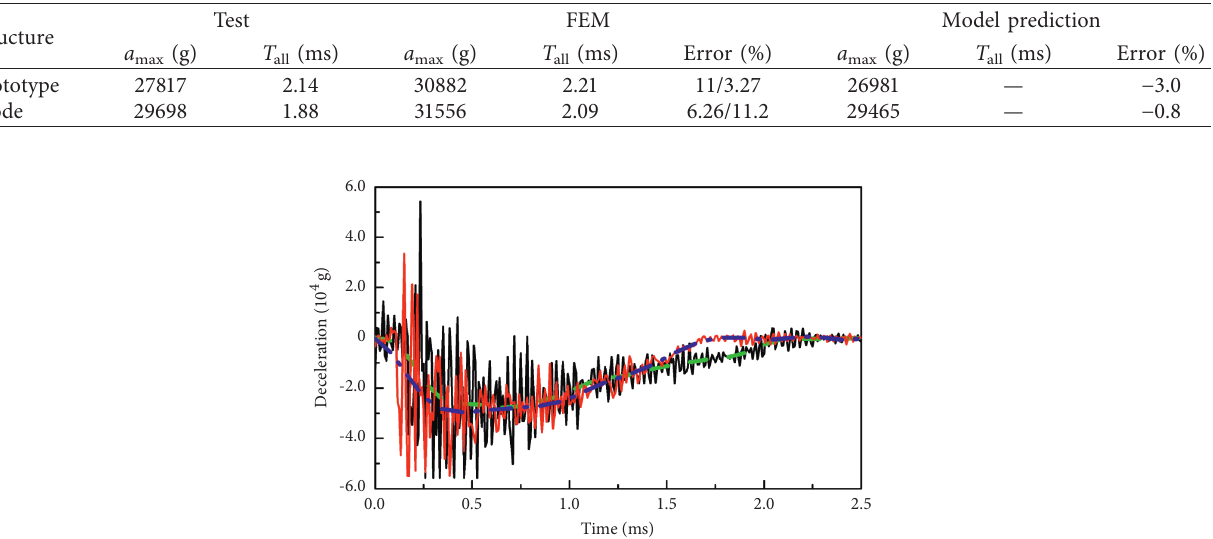
Table 7: Detailed comparison of rigid-body deceleration for the test, FEM, and model prediction.